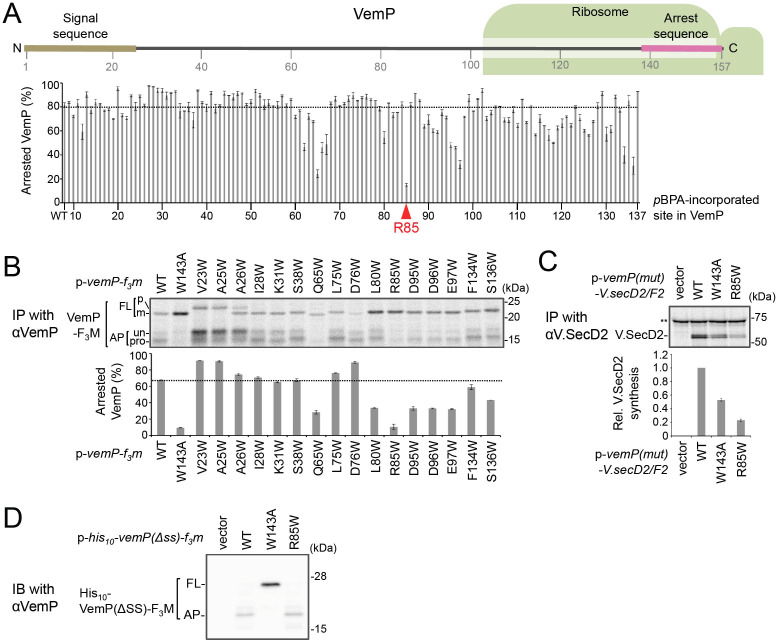
The conserved Arg-85 residue is important for the stability of the arrested VemP in vivo.(A) Stability of the arrested state of the VemPpBPA variants. A schematic picture of the VemP polypeptide in the arrested state is presented with residue numbers. Arrested VemP (%) was calculated from the results in Figure 1. The mean values of arrested VemP (%) are shown with S.D. (n = 2 technical replicates). (B) Effects of Trp mutations on the VemP translation arrest. Cells were grown, induced to express the indicated VemP-F3M derivative, and pulse-labeled as in Figure 1. After 30 s of chase, total cellular proteins were acid-precipitated, subjected to IP with an anti-VemP antibody and analyzed as in Figure 1. Arrested VemP (%) was calculated and the mean values are shown with S.D. (n = 2 technical replicates). (C) WT cells carrying an empty vector or a vemP-V.secD2/F2 plasmid (the indicated mutation was introduced into the vemP gene on the plasmids), were grown and induced as in Figure 1 and pulse-labeled for 1 min. Labeled proteins were then subjected to IP with an anti-V.SecD2 antibody and analyzed as in Figure 1. Double asterisks indicate an un-related protein precipitated with the anti-V.SecD2 antibody. The intensity of V.SecD2 band was quantitated and the relative mean values (the value for WT cells carrying p-vemP-V.secD2/F2 was set to 1) are shown with S.D. (n = 3 technical replicates). (D) Effect of an Arg85 mutation on the translation arrest of a VemP variant lacking its signal sequence. Cells of HM1742 carrying a plasmid, pTV118N-his10-vemP(Δsignal sequence)−3xflag-myc, into which the indicated mutation had been introduced, were grown, induced with 1 mM IPTG for 60 min, and acid-precipitated. Proteins were analyzed by immunoblotting using the anti-VemP antibody. See Figure 5—figure supplement 1—source data 1 for gel images and quantitated band intensities data for A-C.Figure 5—figure supplement 1—source data 1.Zip file containing gel images and quantified band intensity data for the pulse-labeling experiments.